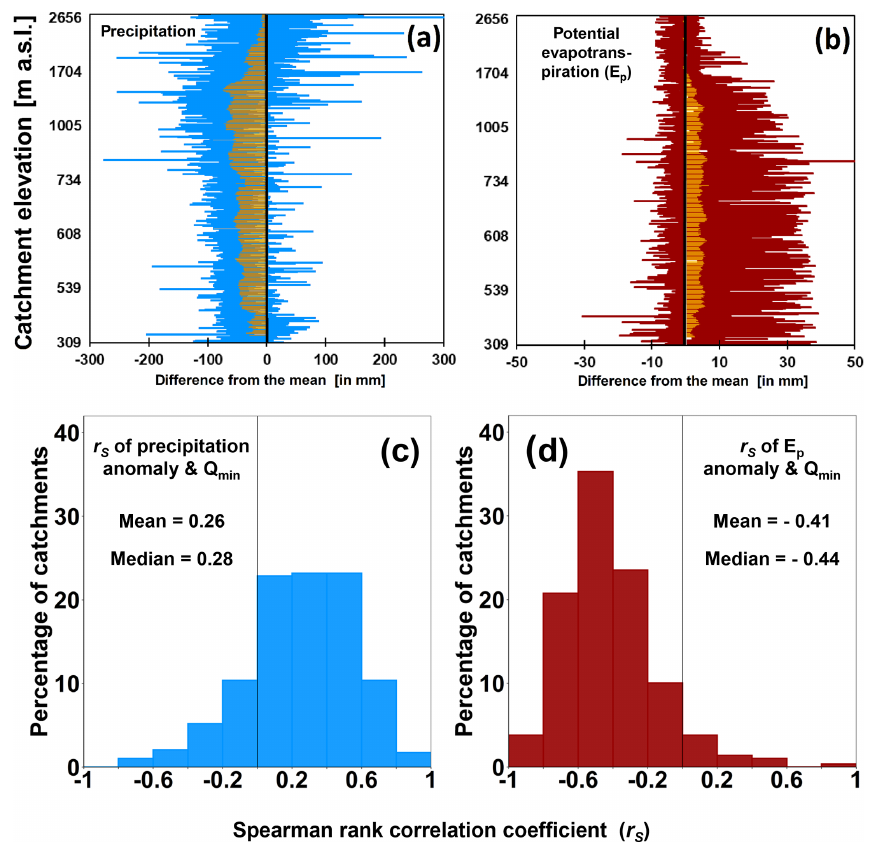
Figure 2. Elevational variation in 30d anomalies of precipitation (a) and potential evapotranspiration (b) preceding (warm- and cold-season) annual low flows from 2000 through 2018. Blue and red horizontal bars indicate the range between the minima and maxima of these anomalies at each catchment across the 19 years of this study. Yellow bars show moving averages of these climate anomalies for bins of 10 catchments ordered by elevation. Note that the elevation scale is not linear. Low flows are associated with below-average precipitation (a) and above-average potential evapotranspiration (b) . Histograms of rank correlations between anomalies of precipitation (c) and potential evapotranspiration (d) and low-flow magnitudes for warm-season (May through November) low flows across Swiss catchments. Results for cold-season low flows can be found in Fig.